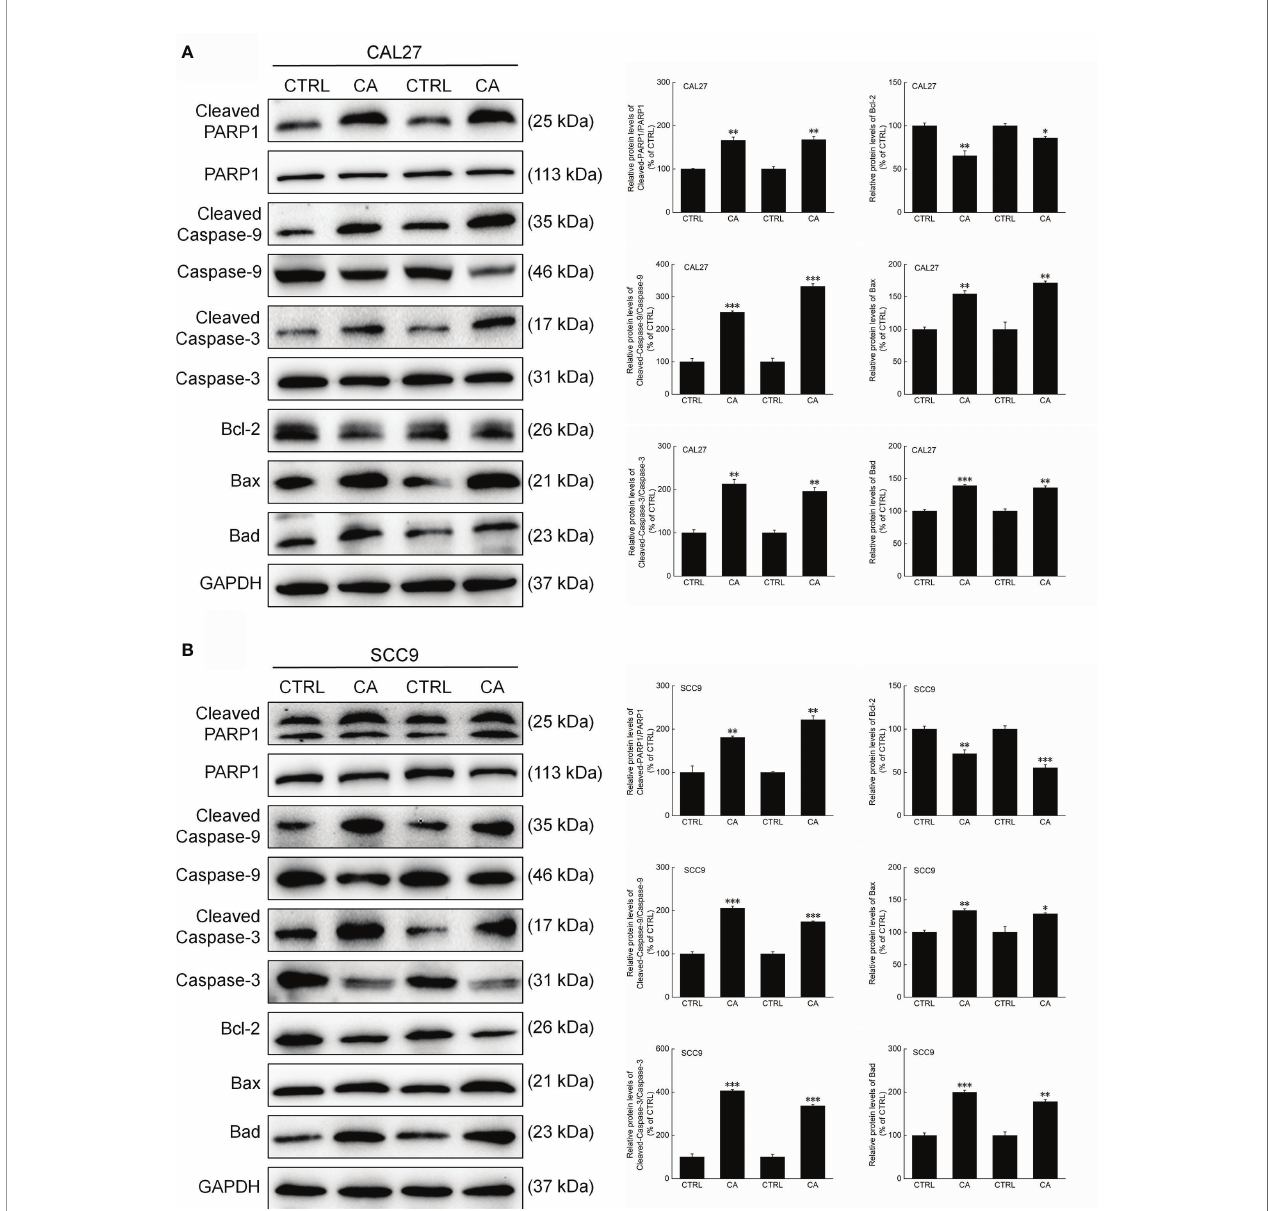
FIGURE 6 | CA treatment changed the levels of apoptosis-related proteins in the tumor tissues collected from the BALB/c nude mice transplanted with OSCC cells. CA treatment signi fi cantly enhanced the ratios of Cleaved PARP1/PARP1, Cleaved Caspase-3/Caspase-3, and Cleaved Caspase-9/Caspase-9; downregulated Bcl- 2 and upregulated Bax and Bad in the (A) CAL27- and (B) SCC9-xenografts in BALB/c nude mice ( n = 3). The target-protein levels were normalized using the GAPDH levels, and the data are expressed as mean ± SEM. * P < 0.05, ** P < 0.01 and *** P < 0.001 versus CTRL